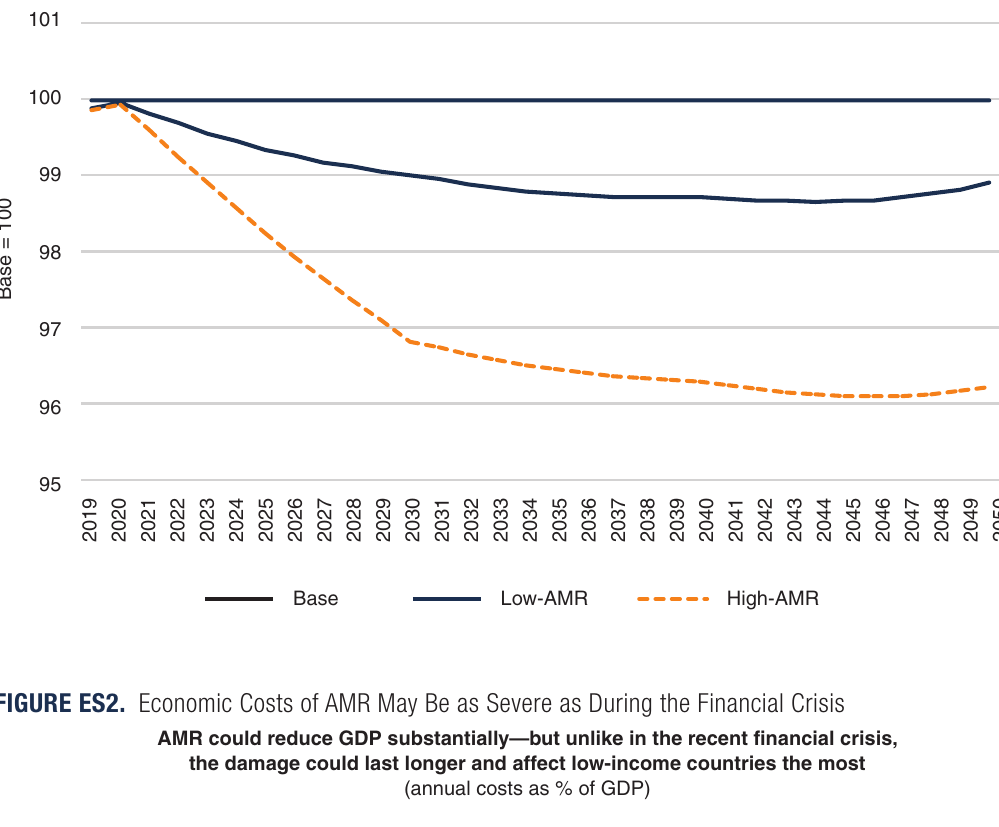
FIGURE ES1. Substantial and Protracted Shortfalls in Global Economic Output